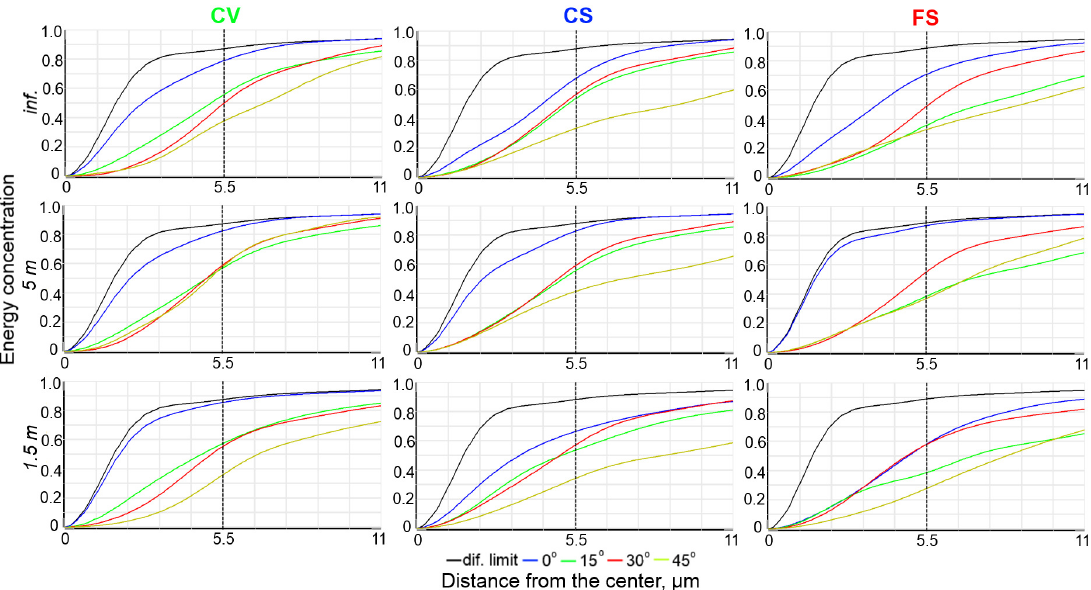
Figure 4. Energy ensquared in one (11 µ m × 11 µ m) and four (22 µ m × 22 µ m) pixels for different designs and different object positions.